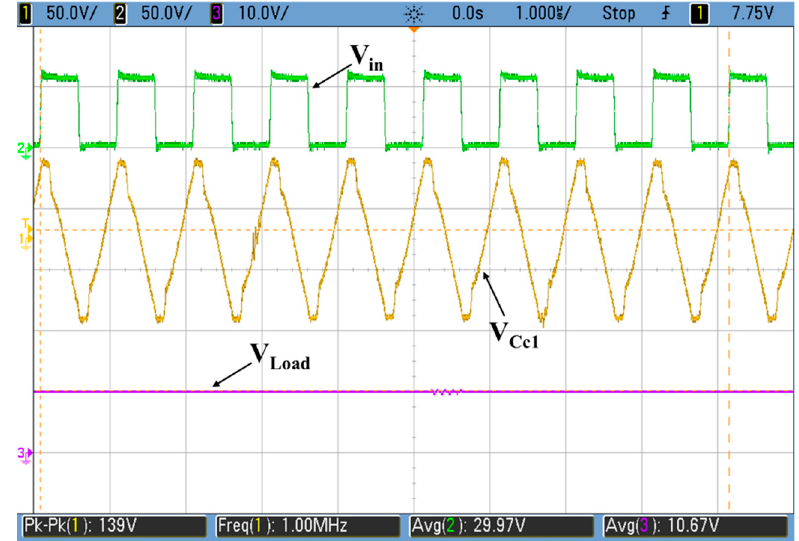
Figure 17. Waveforms of the input AC voltage, voltage across the coupling capacitor, and the DC output voltage.